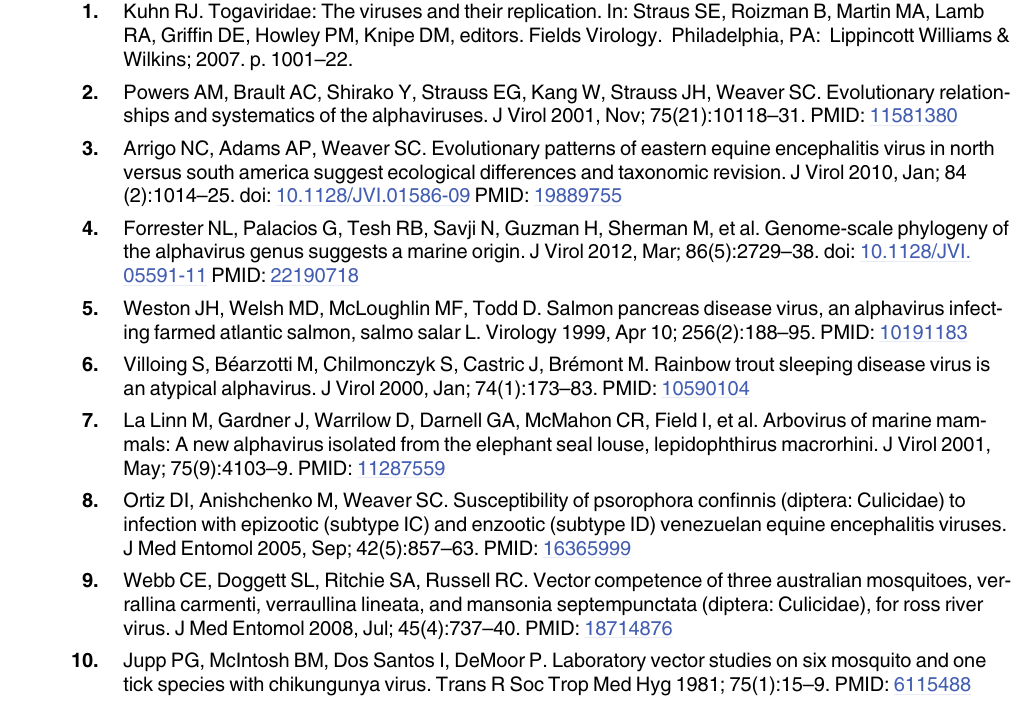
S1 Table. Optical density values of serum samples negative by PRNT used to calculate cut- off values for IgM and IgG